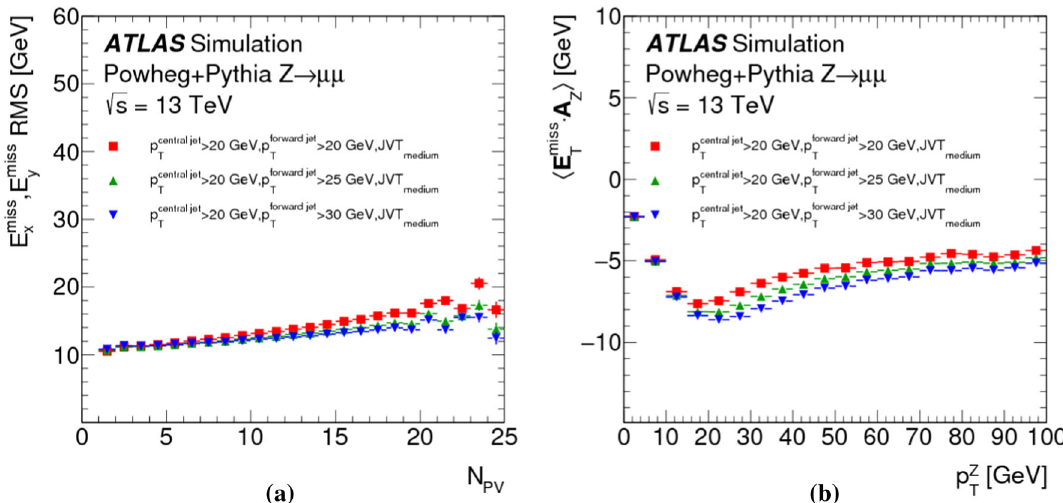
Fig. 19 E miss resolution and scale for different regional jet- p T thresh- of the Z boson. The same thresh- of the transverse momentum p Z T T old is applied to the transverse momentum of jets within | η | < 2 . 4 olds, for Z → μμ events in MC simulation. The a E miss resolution is T > 20GeV), while for forward jets with | η | ≥ 2 . 4 threshold shown as function of the pile-up activity measured by the number of ( p central jet T primary vertices N PV , and the b E miss response is shown as function > { 20 , 25 , 30 } GeV) are variations ( p forward jet T T